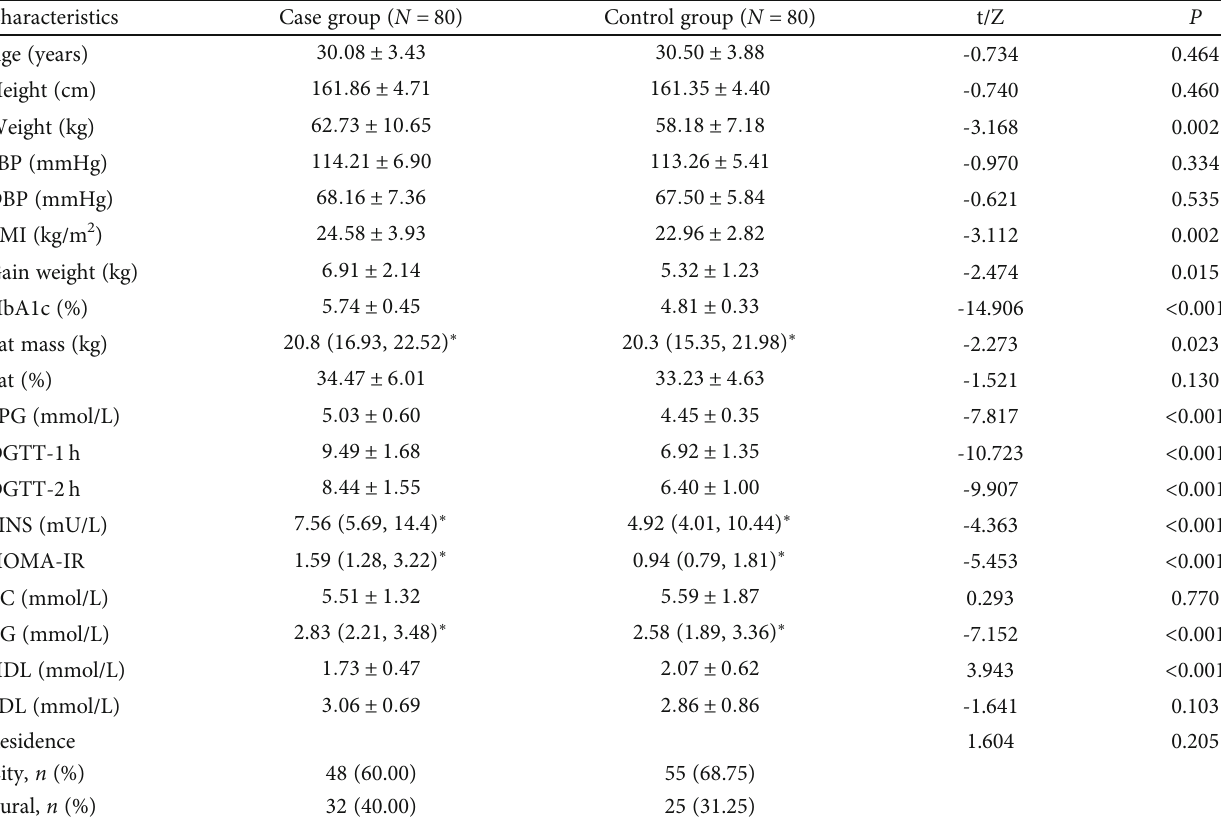
Table 1: The clinical and metabolic characteristics of the two groups.